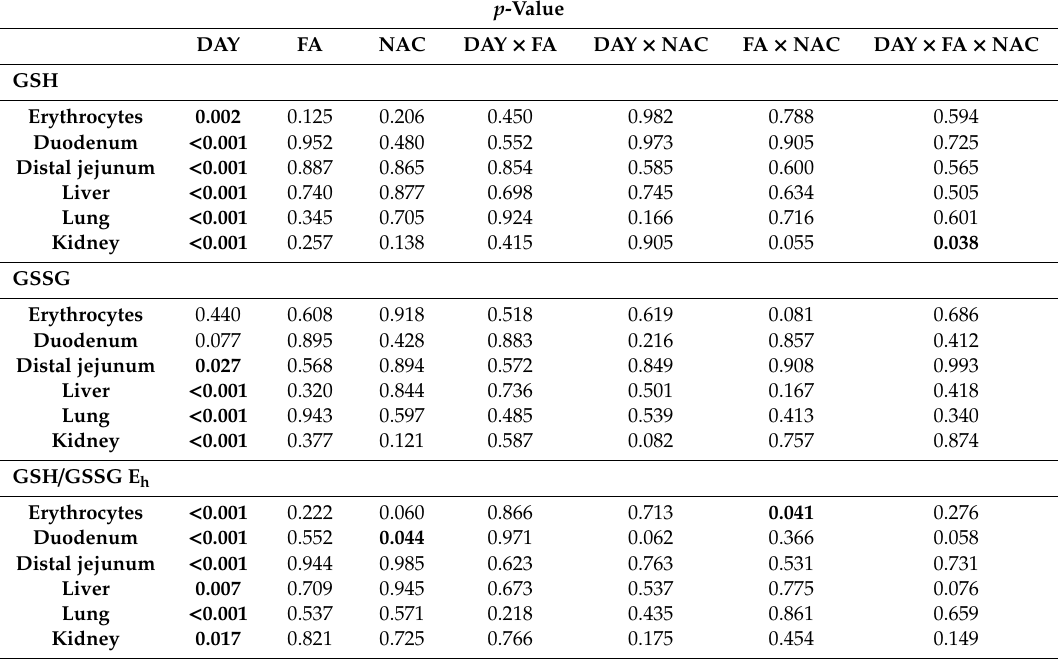
Table 3. Results for the GSH and GSSG levels, and the GSH redox status are represented in Figures 1–5. Table 3. Significance levels for treatment e ff ects on the glutathione redox system in piglets at d0, d2, and d14 post-weaning (DAY), either or not fasted from d0–2 (FA), and either or not supplemented with N -acetyl cysteine via the drinking water at 200 mg / L (NAC) ( n = 4). p